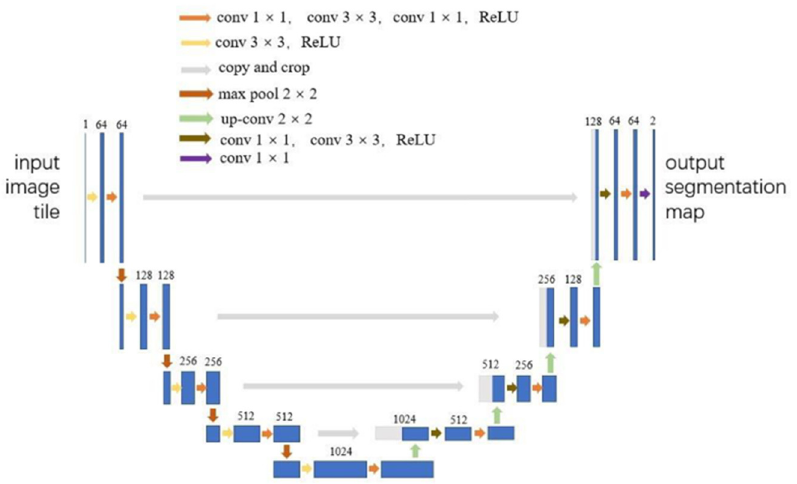
Figure 4. The structure of the improved U-Net [55]: Compared with the original U-net, Wang Z. [58] has made two modifications. First, in order to reduce the amount of calculation, modify conv (3 × 3) to conv (1 × 1) + conv (3 × 3) + conv (1 × 1). In order to reduce the overall parameters, conv (3 × 3) is replaced with conv (1 × 1) when dealing with the same dimension and dimension reduction calculation.